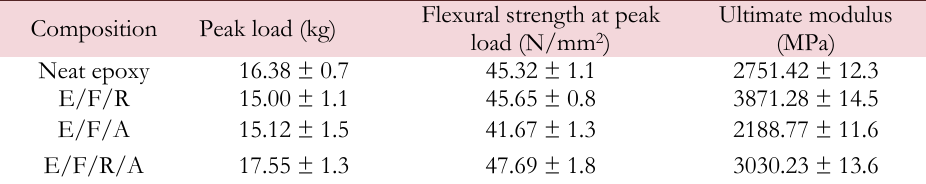
Table 9: Flexural test results of hybrid